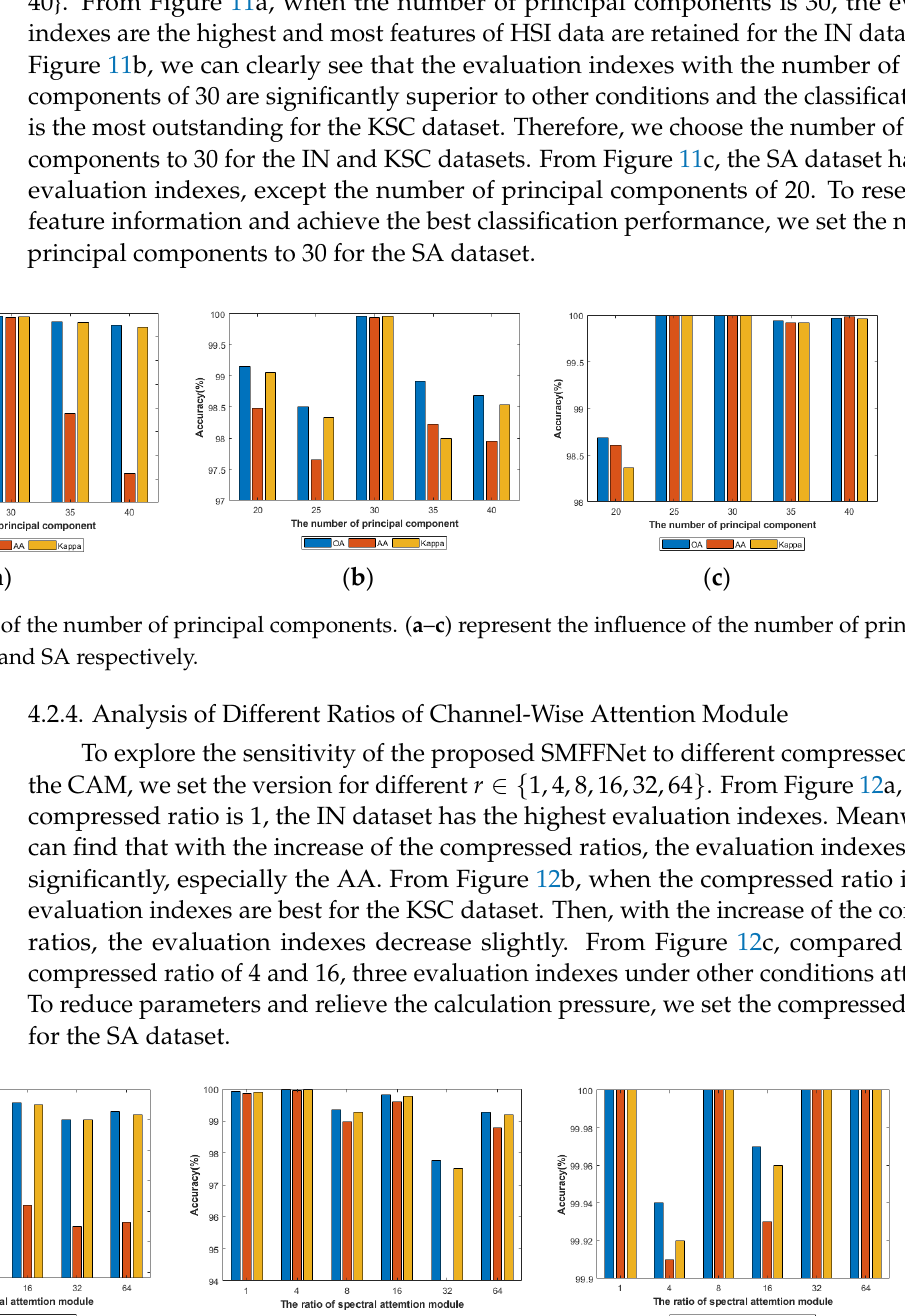
Figure 10. The influence of different spectral and spatial patch sizes. ( a – c ) represent the influence of different spectral patch sizes on IN, KSC and SA respectively. ( d – f ) represent the influence of different spatial sizes patch sizes on IN, KSC and SA respectively.